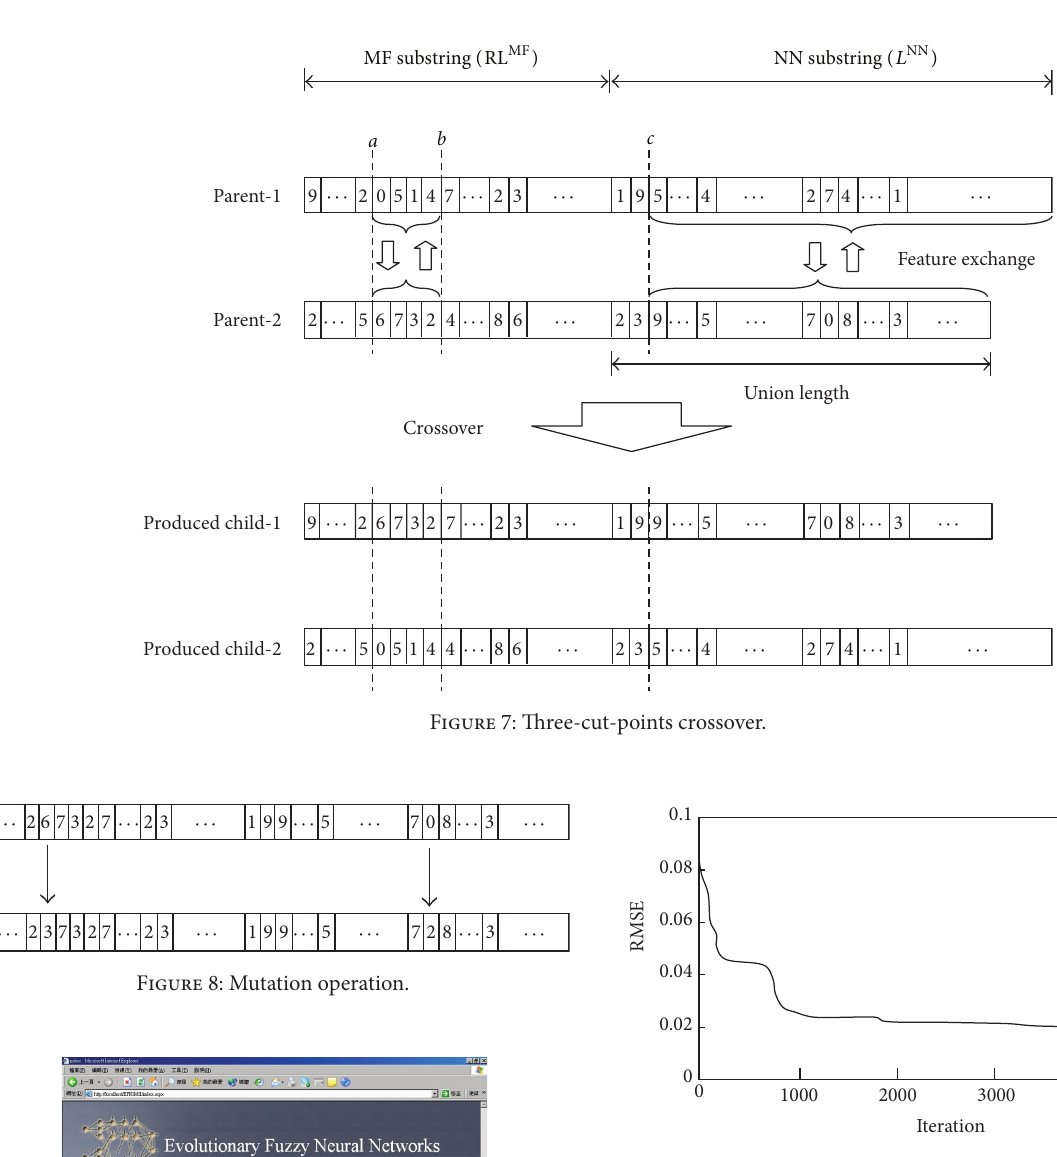
Figure 10: Evolutionary